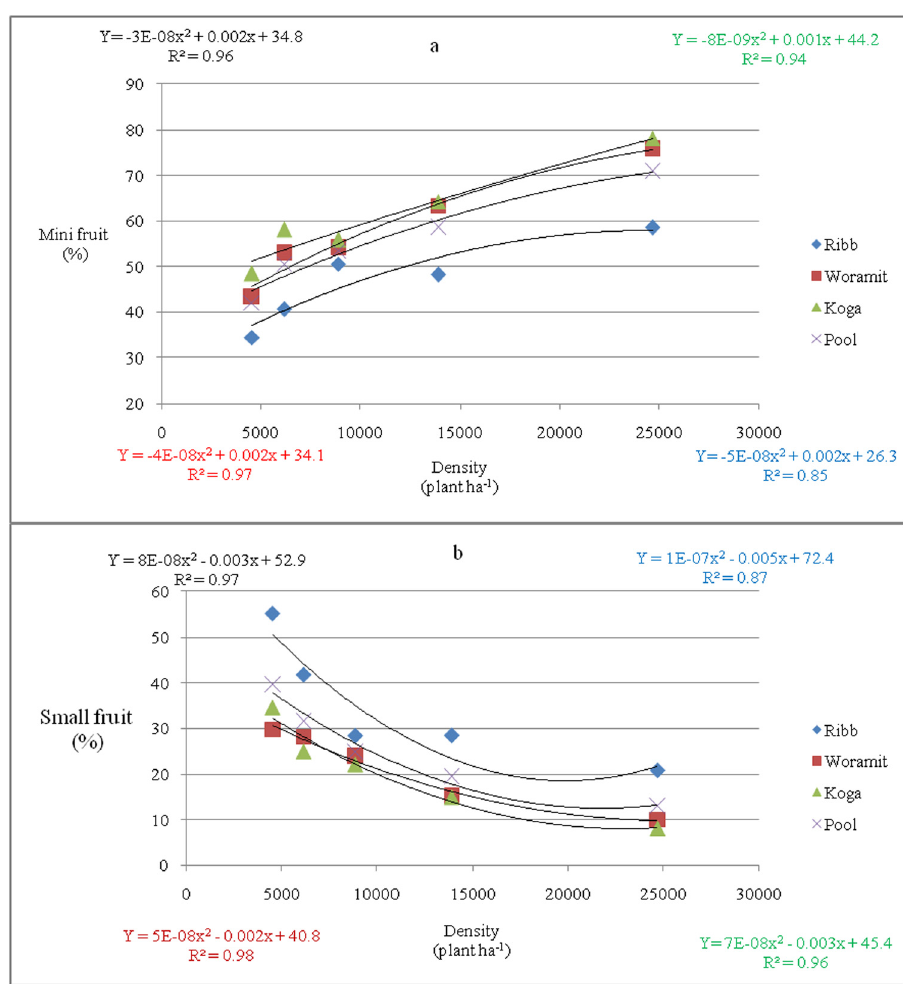
Figure 8: Fruit size distribution: ( a ) mini fruits and ( b ) small fruits trends as a ff ected by plant density